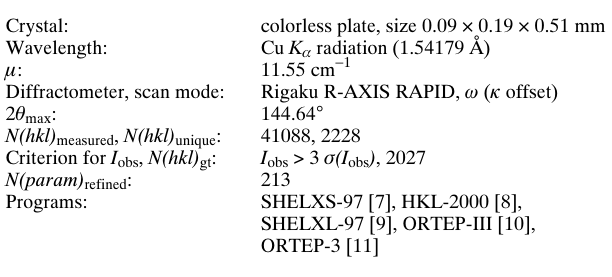
Table 1. Data collection and handling.